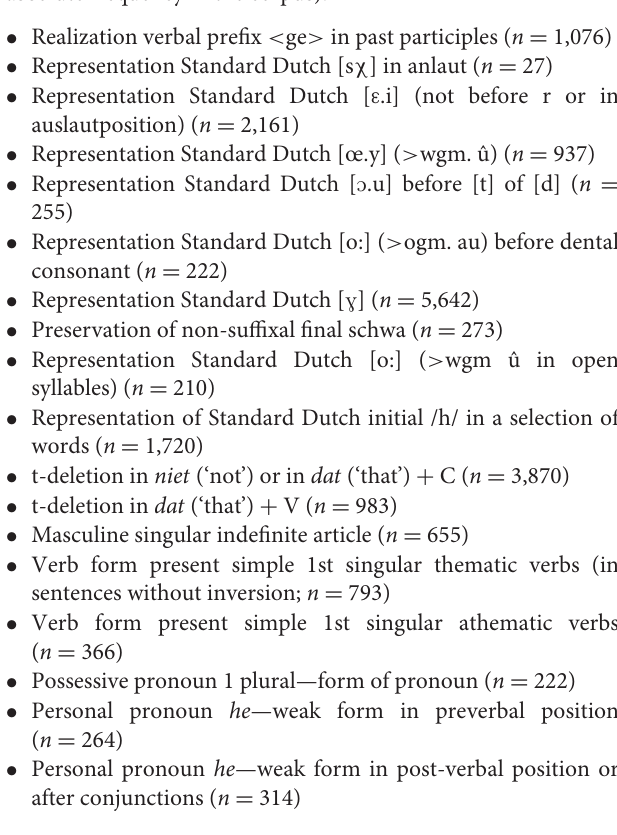
born between 1981 and 1986 and five between 1955 and 1961 7